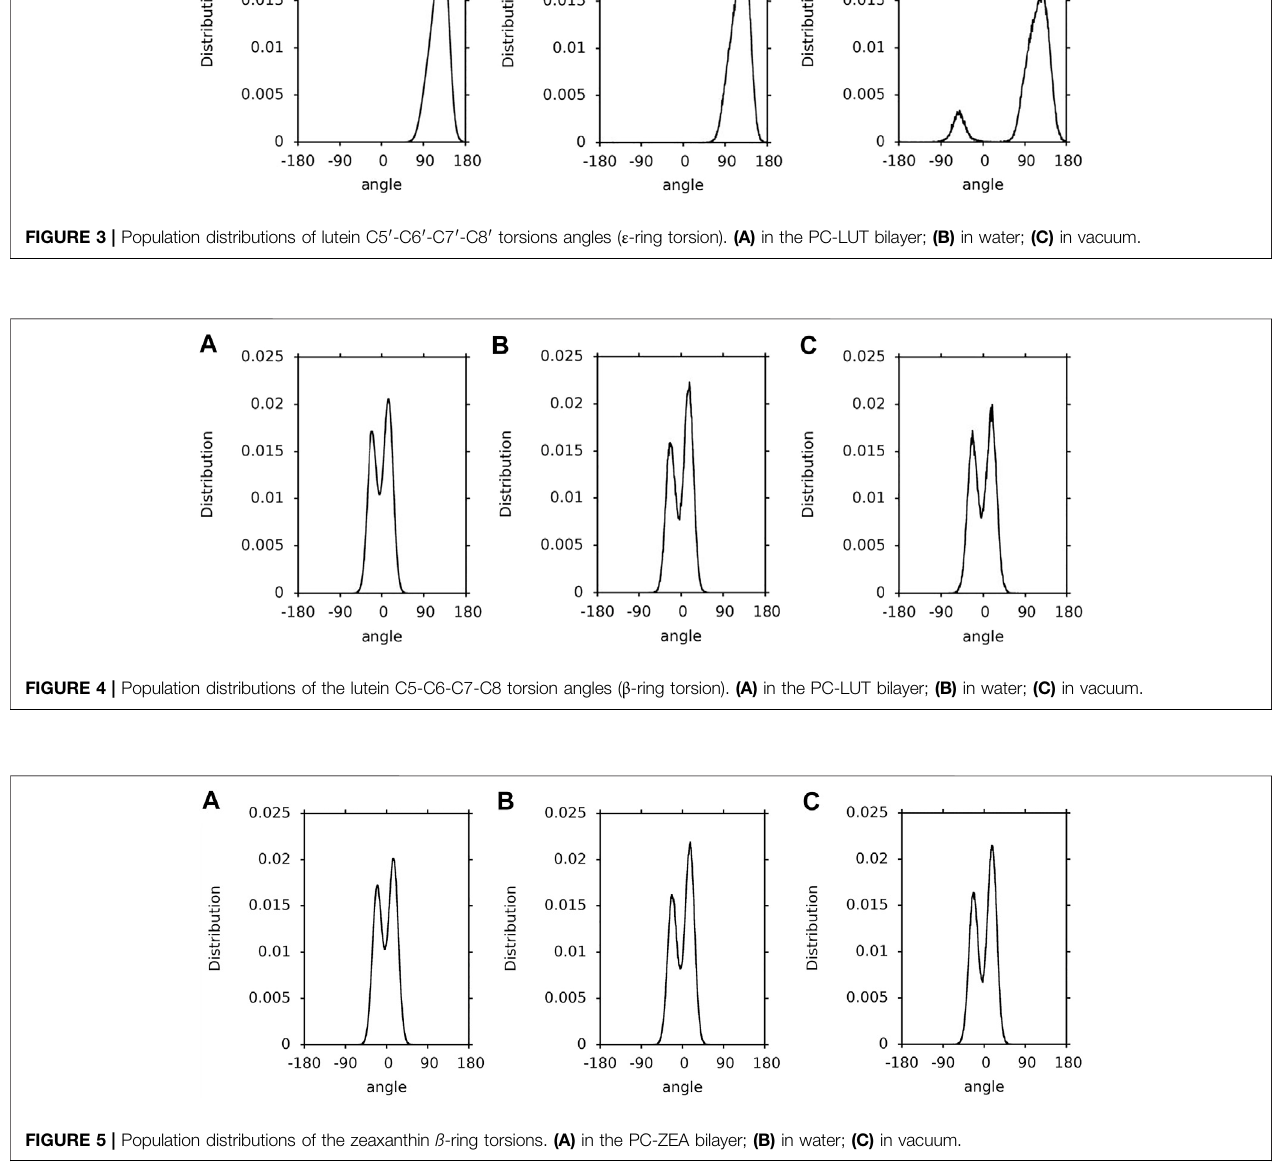
Frontiers in Molecular Biosciences |